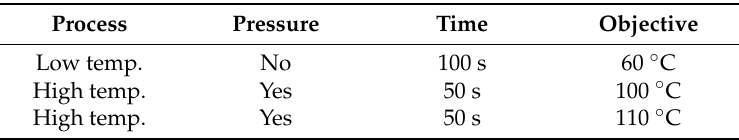
Table 1. Conditions for the